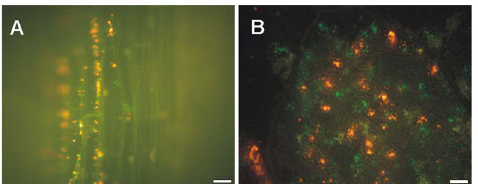
Figure 3. Origin of E.coli cell-aggregates in roots or leaves of colonized lettuce seedlings. Representative fluorescence photomi- crographs of E. coli K12-colonized (A) roots or (B) leaves after the inoculation of seedlings with a 1:1 mixture of RFP- and GFP-labeled bacteria. Magnifications were at (A) 750X or (B) 150X. White bars correspond to (A) 10 m m or (B) and 20 m m.